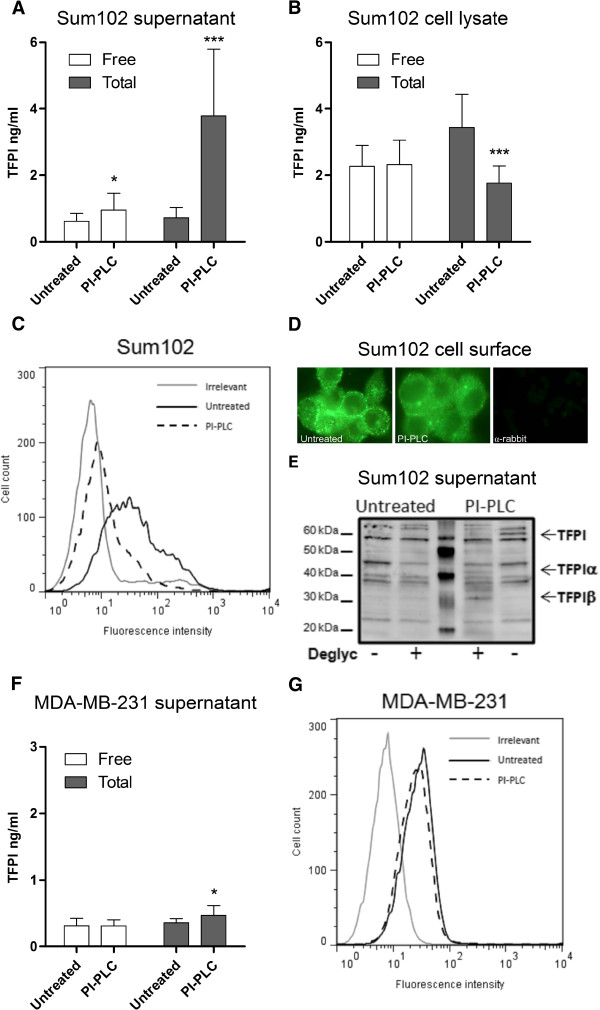
PI-PLC treatment of Sum102 and MDA-MB-231 cells. Serum-starved cells were treated with SFM (untreated) or PI-PLC (1 U/mL) for 2 hours before the supernatant was removed and cells lysed or collected for flow cytometry analysis. Total and free TFPI antigen measured in the supernatant (A and F) and lysate (B) of untreated and PI-PLC treated Sum102 (A and B) and MDA-MB-231 (F) cells. Mean values + SD (n ≥ 8) of three to six independent experiments are presented. All statistical comparisons were conducted between PI-PLC treated samples and untreated controls. Flow cytometry analysis of untreated (black, solid) and PI-PLC treated (black, broken) Sum102 (C) and MDA-MB-231 (G) cells. One representative experiment of three is shown. (D) Fluorescence images of SFM + glycerol (untreated, left panel) and PI-PLC (middle panel) treated Sum102 cells stained with antibody against both isoforms of TFPI. The right panel shows a secondary antibody background control staining. One representative experiment of three is shown. (E) Western blot of supernatants from SFM + glycerol (untreated) and PI-PLC treated Sum102 cells. Samples were deglycosylated and incubated with a polyclonal anti-human TFPI antibody.